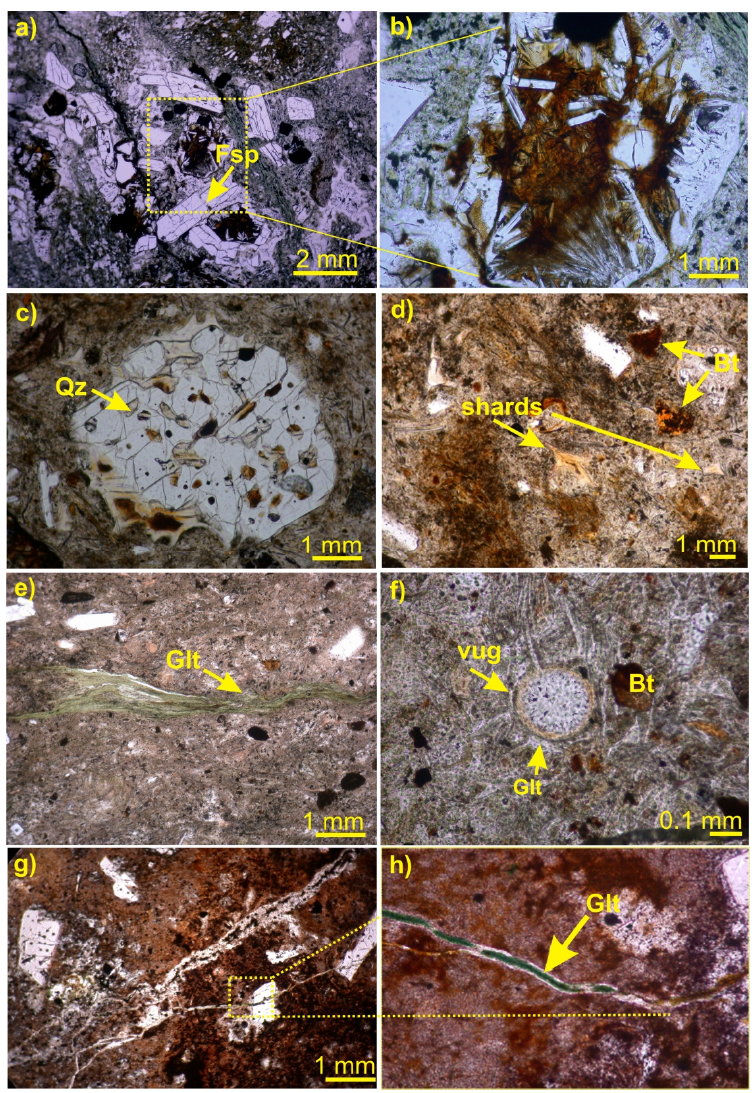
Figure 5. Microphotographs showing textural and mineralogical features of selected samples under OM: ( a ) and ( b ) Feldspar with alteration signs in I1 sample under plane polarized light; ( c ) rounded quartz with several micro-voids in H2 sample, under cross polarized light; ( d ) cuspate glassy y-shaped shards partially transformed into clinoptilolite aggregate in the H3 altered epiclastites under cross polarized light; ( e ) glauconite in ashy sample E1a, under plane polarized light; ( f ) vugs filled by clinoptilolite crystals in E2 sample, under plane polarized light; ( g ) glauconite and ( h ) its particular grown in veins crossing the reddish matrix of the sample E1d, under plane polarized light. Note the vein-filling or fluid-miming aspect of glauconite mineralization in (e) and (h). Abbreviations: Fsp: feldspar; Qz: quartz; Glt: glauconite; Bt: biotite.